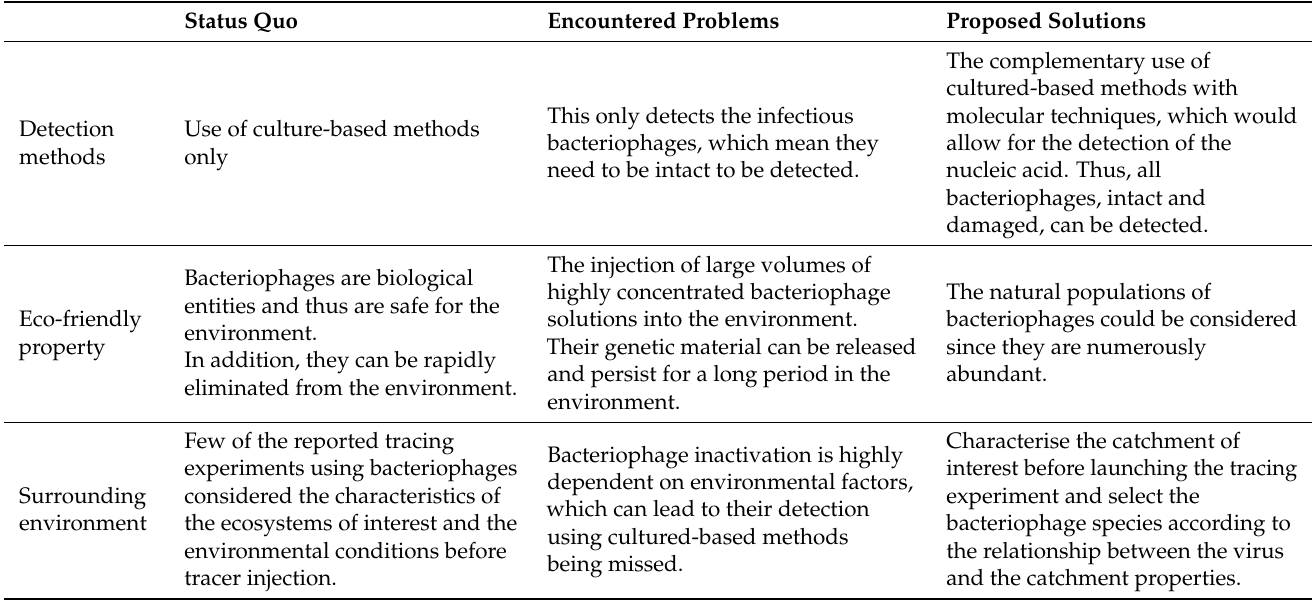
Table 3. The three main issues in the use of bacteriophages as hydrological tracers with their limitations and the proposed